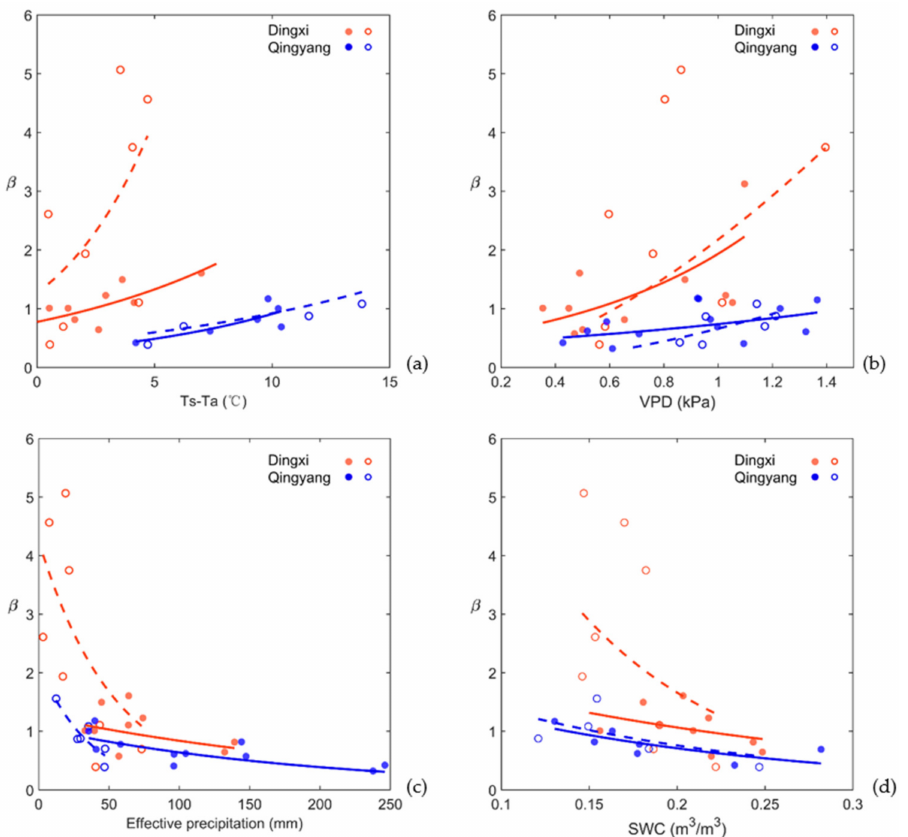
Figure 10. Relationship between environmental factors and β under different moisture conditions. The solid and hollow dots represent wet and dry conditions, respectively. The red and blue dashed line are the relationships of ( a ) Ts − Ta , ( b ) VPD , ( c ) effective precipitation, ( d ) SWC , and β in Dingxi and Qingyang, respectively. Table 5. Statistical relationships between environmental factors and the Bowen ratio under dry and wet